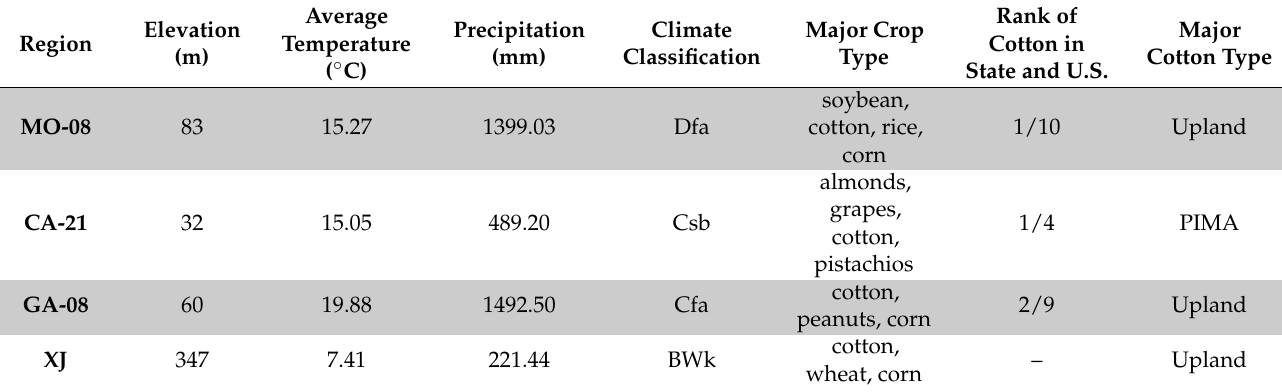
Figure 2. Study sites. Table 1. Climatological and agricultural characteristics of different